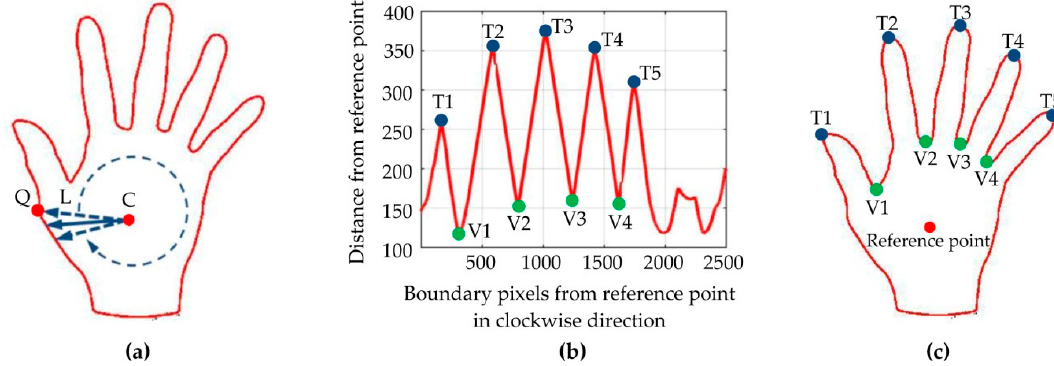
Figure 5. Robustness of hand centroid point extraction of distance transform image.